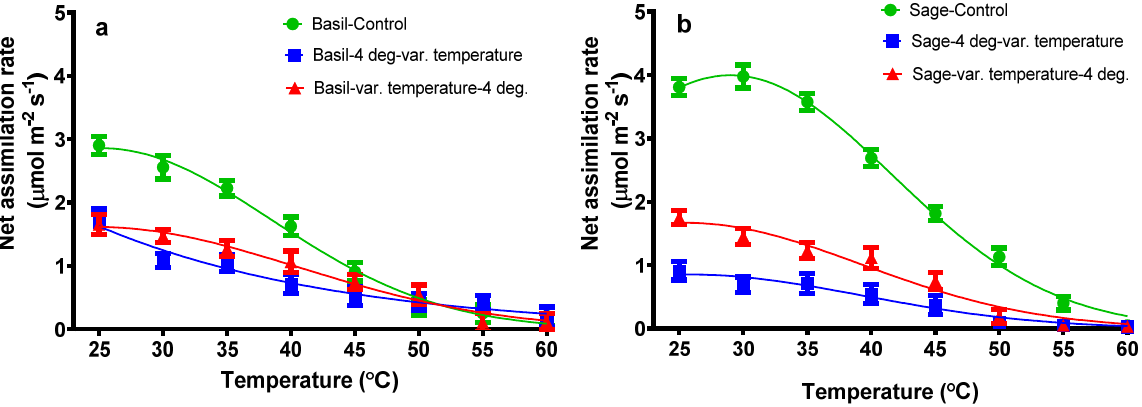
Figure 1. The net assimilation rate from basil plants ( a ) and sage plants ( b ) plants subjected to different temperatures. The values are averages of three individual measurements.